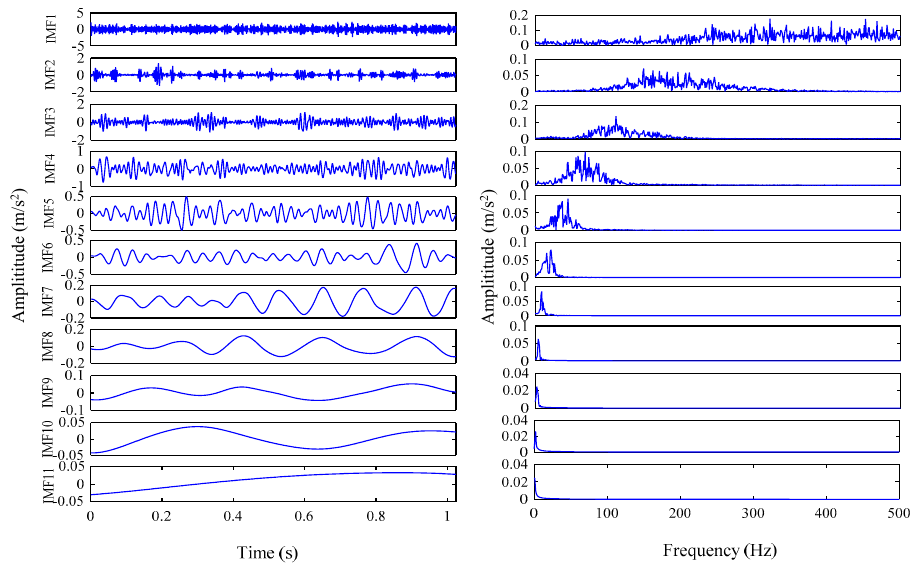
Figure 5. Decomposition results and corresponding frequency spectrum of IMFs with Ensemble EMD (EEMD).